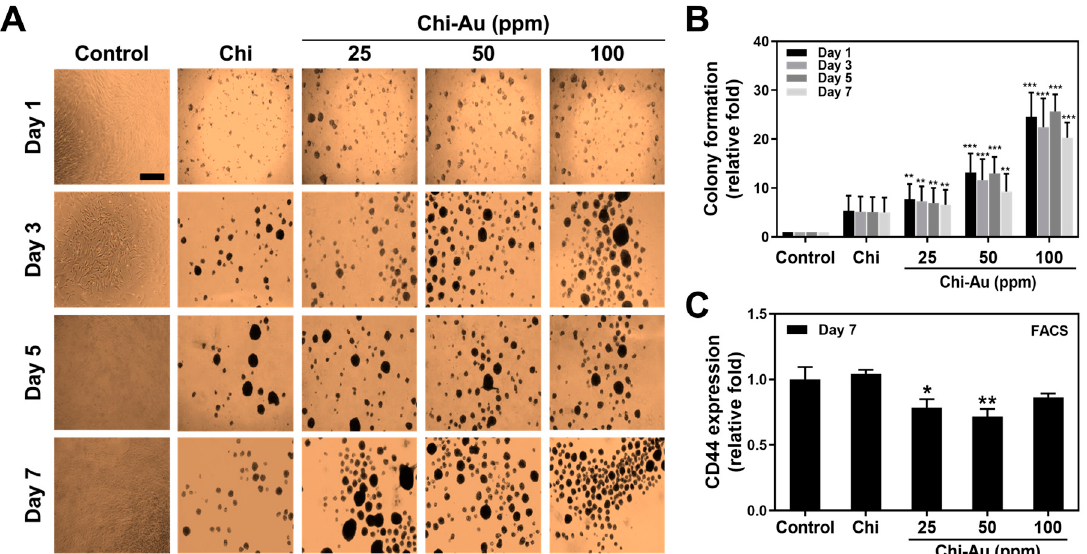
Figure 2. Colony formation and CD44 expression of MSCs cultured on Chi–Au nanocomposites. ( A ) Colony formation ability and ( B ) colony formation number of MSCs were observed at 1, 3, 5, and 7 days. Furthermore, ( C ) the expression of the CD44 marker at Day 7 was semi-quantified by the fluorescence-activated cell sorting (FACS) method. The results demonstrated that Chi combined with Au could induce the proliferation capacities of MSCs, particularly at the concentrations of 50 and 100 ppm of Au nanoparticles. Additionally, the CD44 expression was explored to be significantly lower in the Chi–Au 25 and 50 ppm groups. The scale bar to observe colony formation was 100 µ m. Data are exhibited as the mean ± SD ( n = 3). * p < 0.05, ** p < 0.01, *** p < 0.001: compared with the control (TCPS).